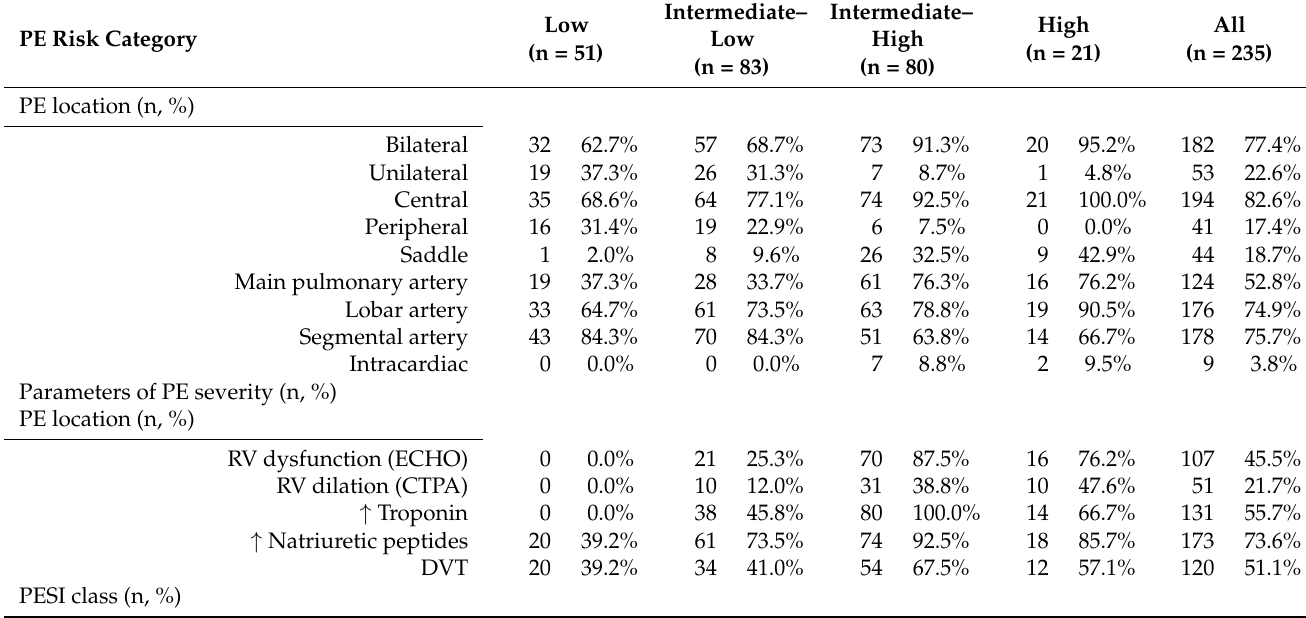
Table 2. Characteristics of PE categorized according to the risk of early